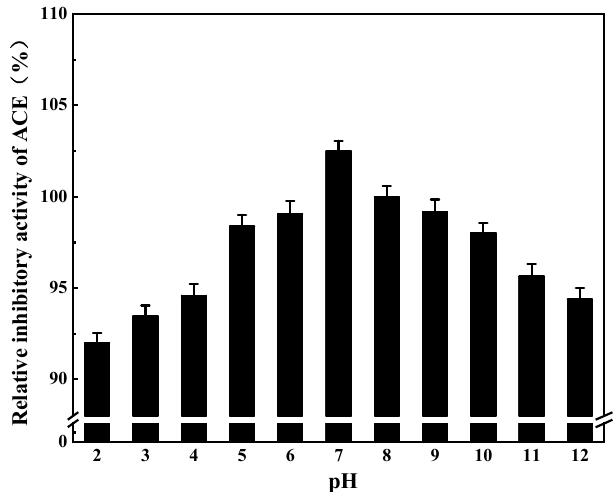
Figure 16. Stability of ACE inhibitory peptide at different pH levels.